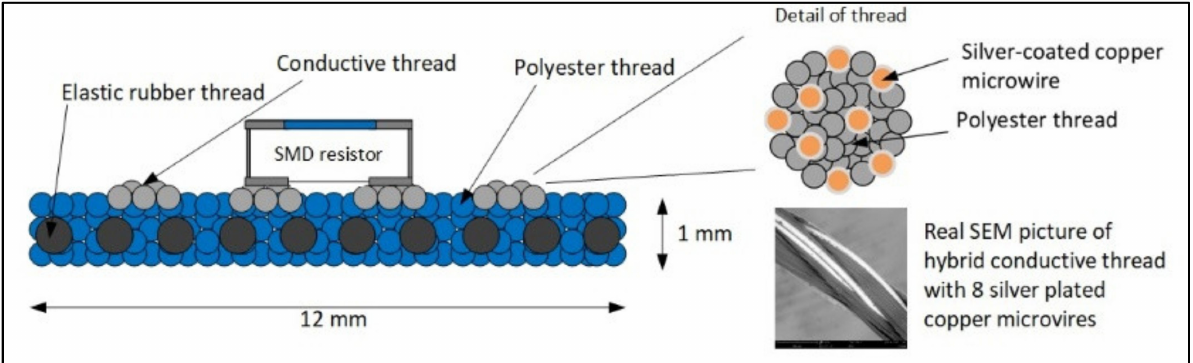
Figure 1. Schematic cross-section of the conductive textile ribbon used in the